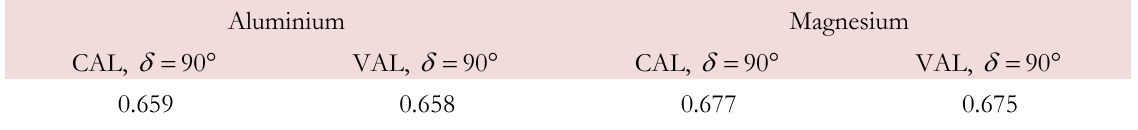
Table 1: Non-proportionality factor according to Kanazawa, plane stress